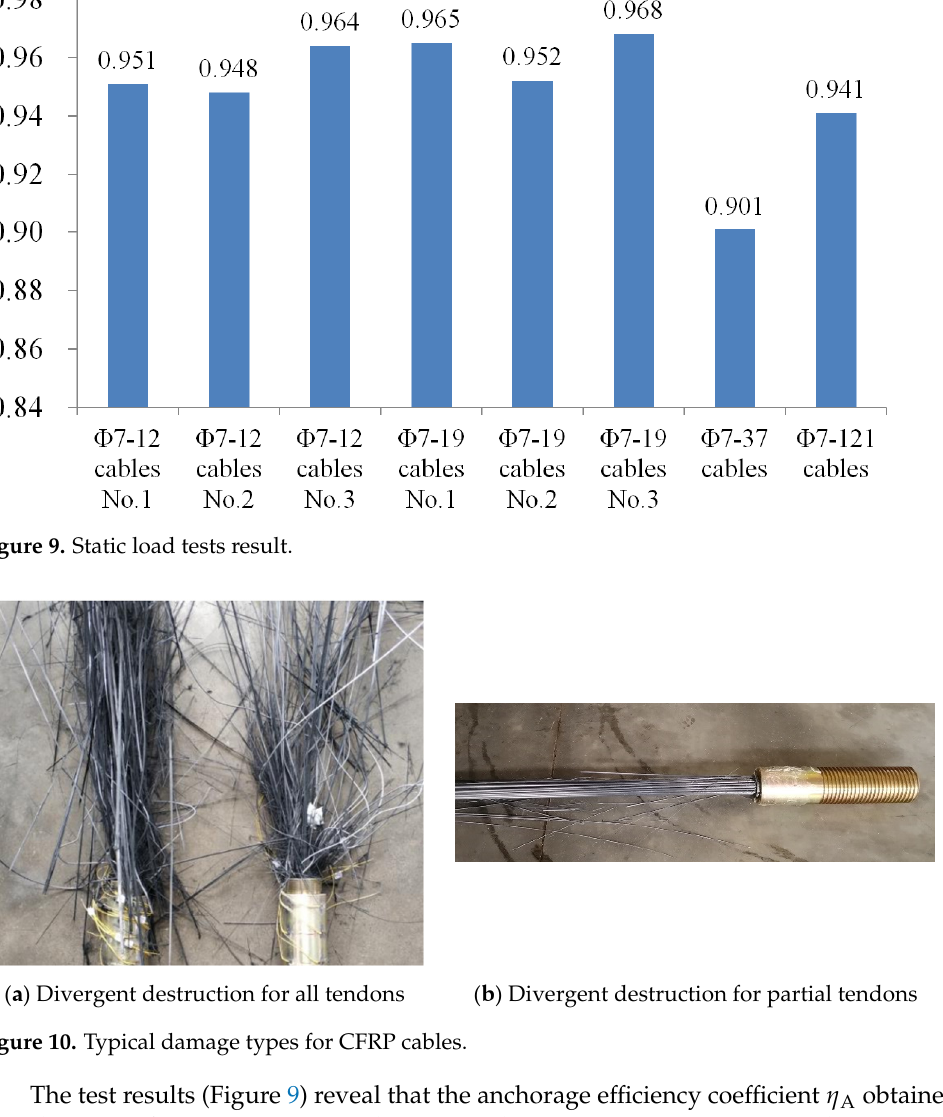
Figure 10. Typical damage types for CFRP cables.